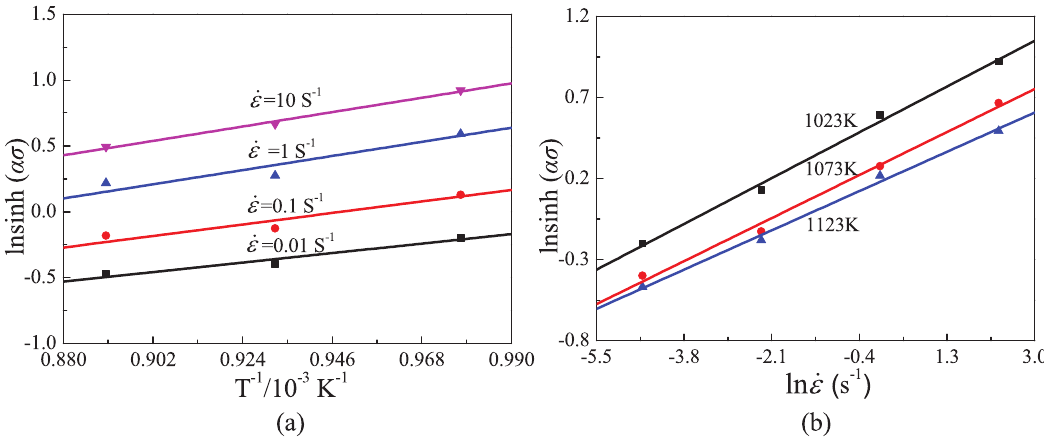
Fig. 5: Relationships between: (a) as ln sinh( ) and 1/ T ; (b) as ln sinh( ) and e 